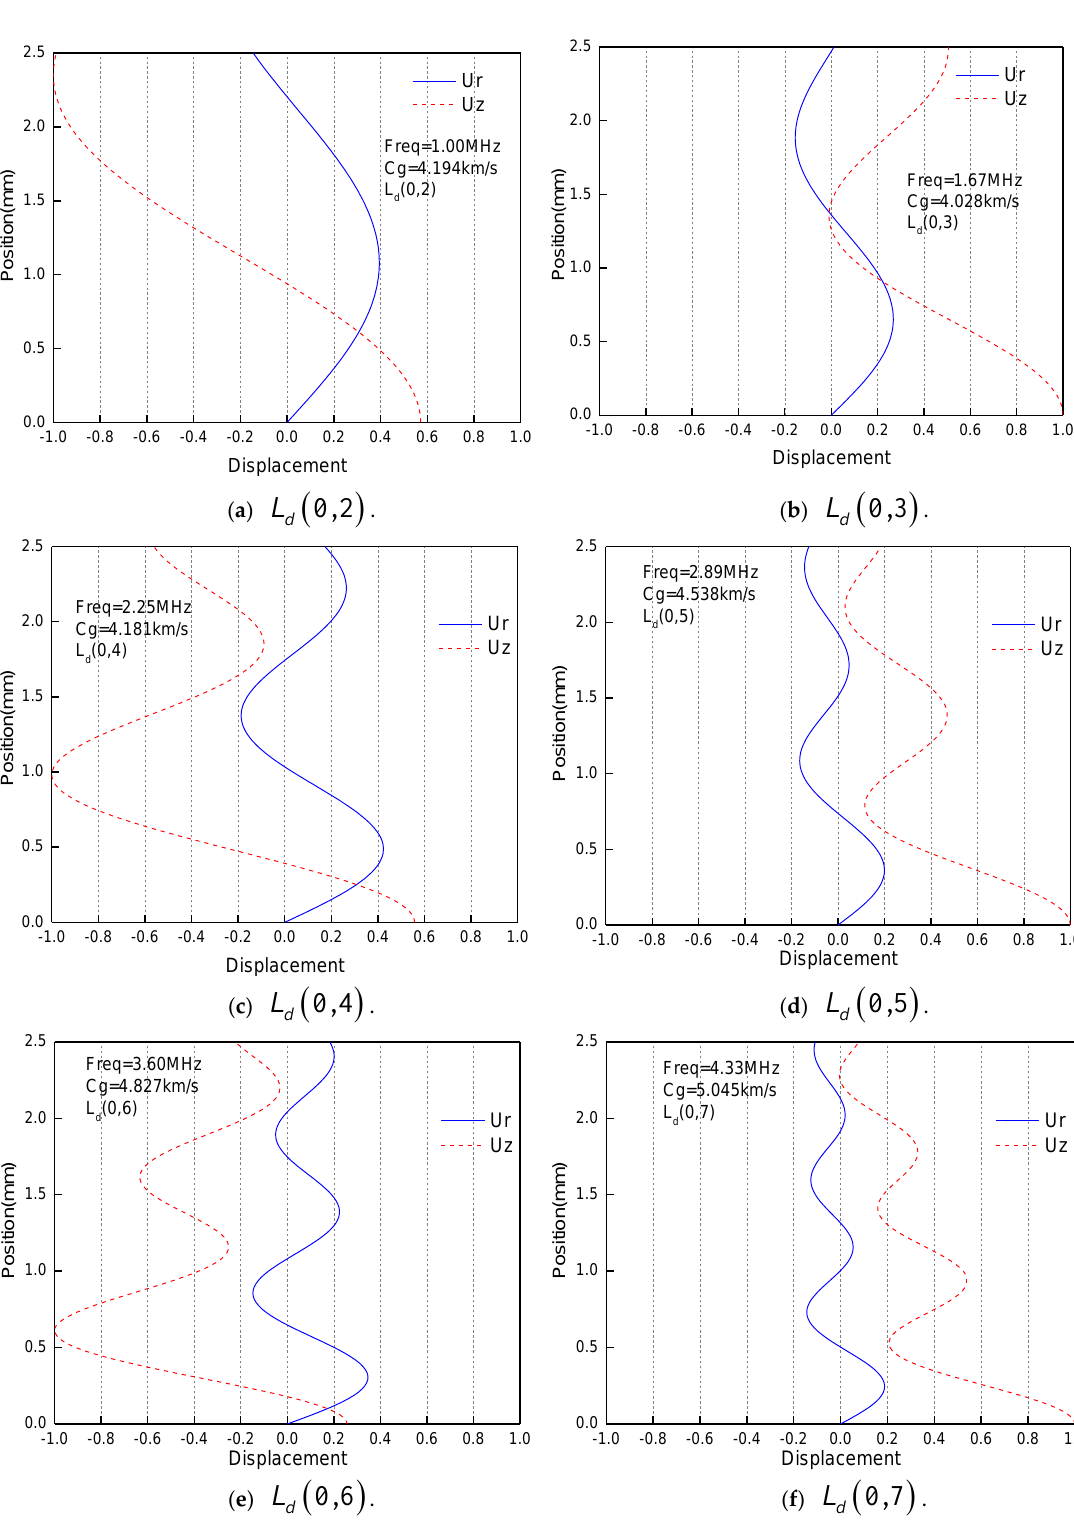
Figure 19. Longitudinal mode at a maximum energy velocity for the damped waveguide: ( a ) L d ( 0,2 )